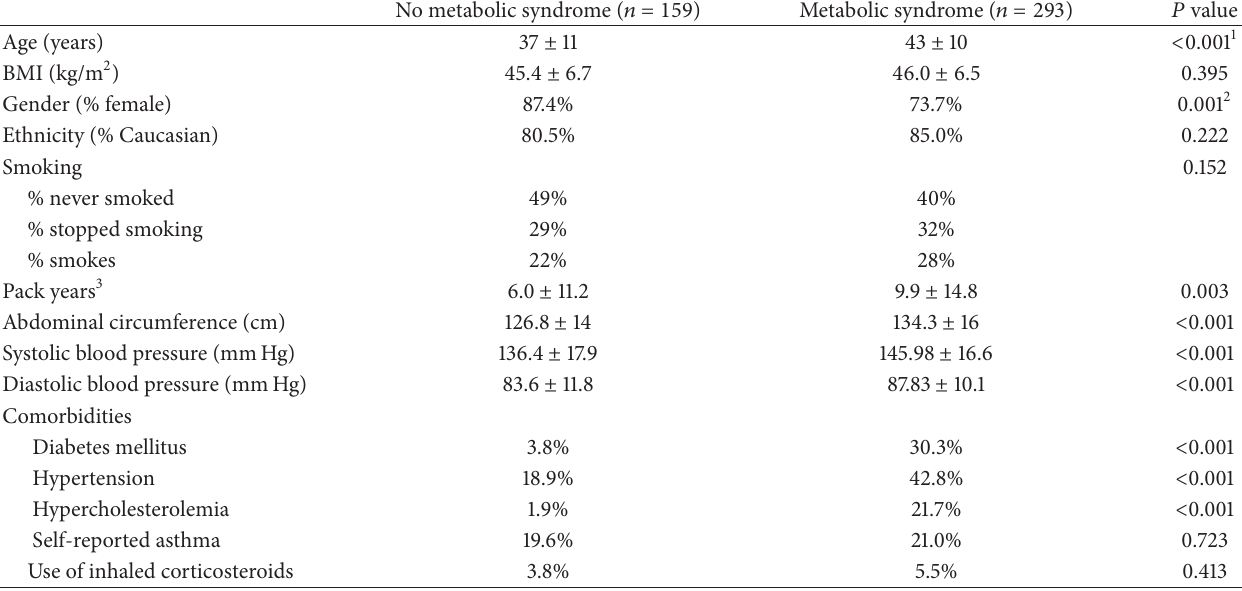
Table 1: General characteristics of the population included in the